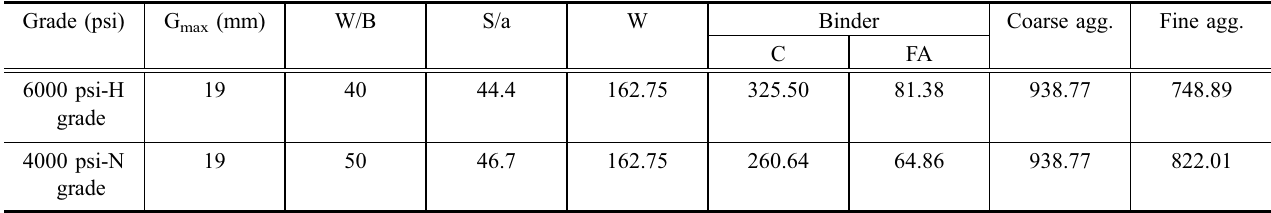
Table 1 Mix proportions for N (4000 psi) and H (6000 psi) grades.